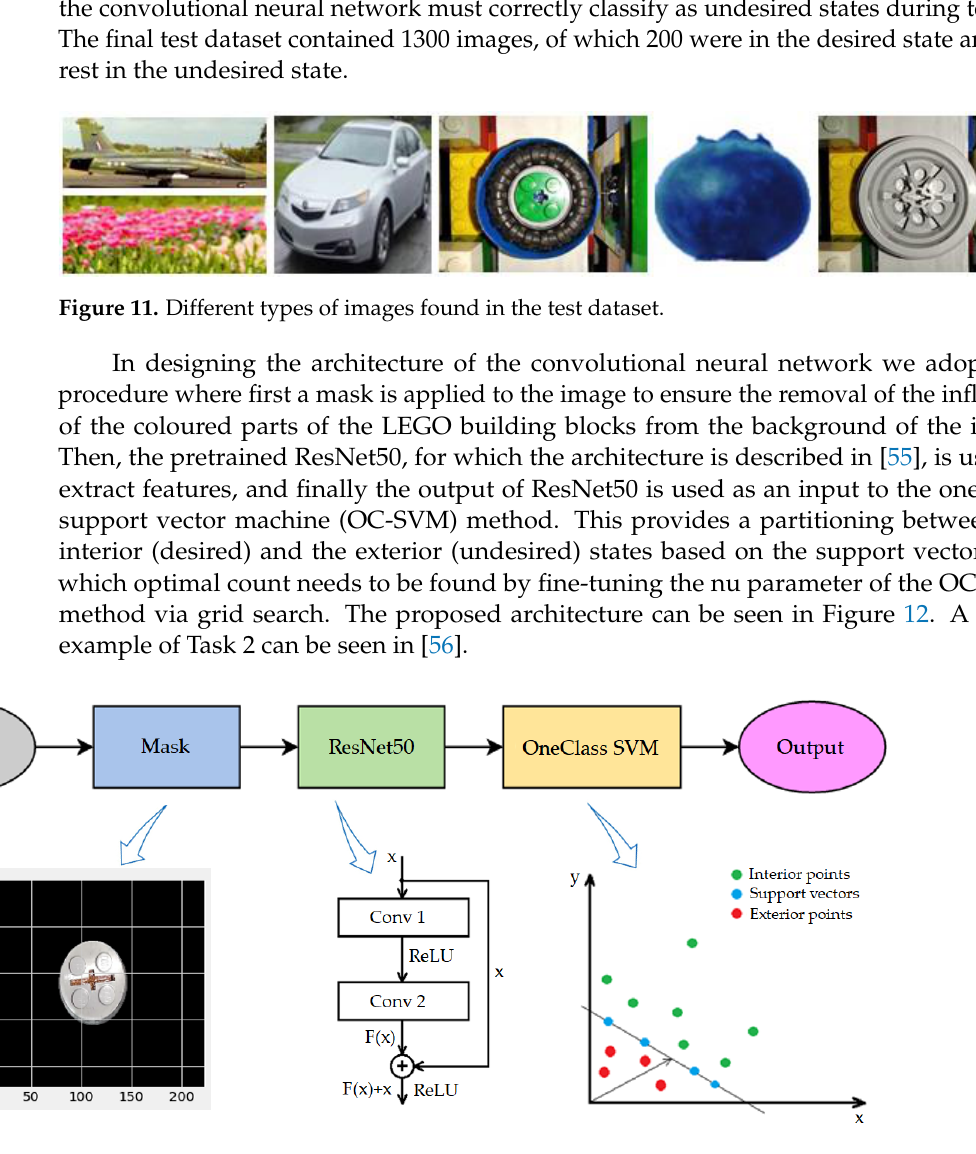
this task, we can only use the images of the products in the desired state from the camera